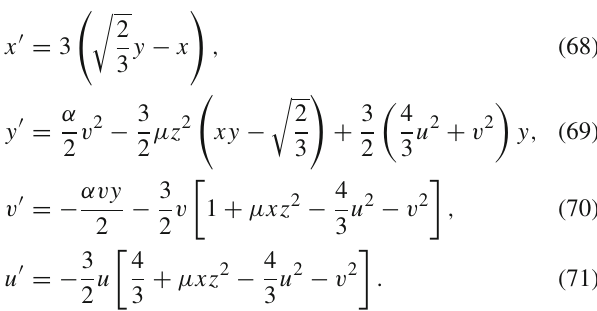
The critical points, existence of critical points and the value of cosmological parameters are shown in Table 4 and the